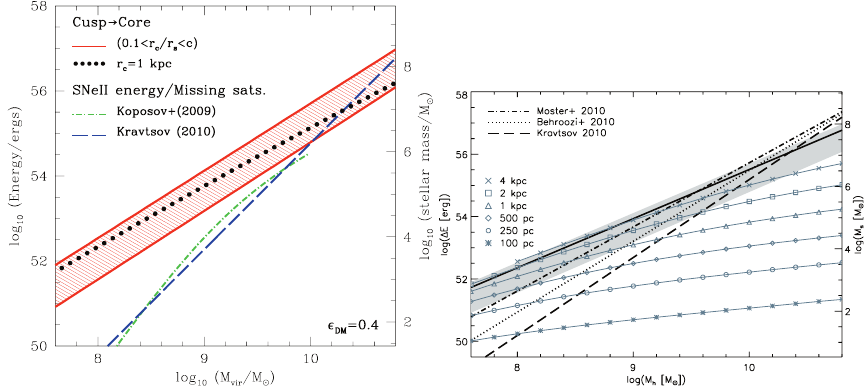
Figure 8. Left panel: SN energetic output with halo mass. The red shaded area represents the minimum energy of SN explosions, ∆ E , needed to generate a core of size 0.1 < r c / r s < c , c , and r s being the concentration parameter and the scale radius of the NFW profile of virial mass M vir , respectively. The dotted black line corresponds to a core of size r c = 1 kpc. The right vertical axis displays the luminosity, in stellar mass, derived from a star formation efficiency F ∗ = F ∗ ( Mvir ) constrained by the number of luminous satellites in our Galaxy. Luminosities are converted into SNeII energy using Equation (6) of Ref. [301] and adopting a strong energy coupling (cid:101) DM = 0.4. The outputs of energy found for SN explosion compatible with the “missing satellite” problem in two different studies [310,311]. The tension between the “core/cusp” and “missing satellite” problems becomes obvious in haloes with M vir < 10 M (cid:12) (panel reproduced from [301]). Right panel: Estimates from Ref. [302] of the energy ∆ E required to convert a dark matter cusp into a core. Similarly to the left panel, the left axis shows SN energy outputs. However, the right axis shows the stellar mass corresponding to ∆ E assuming 100% efficiency ( (cid:101) DM = 1). The energy required to obtain the pseudo-isothermal density profiles, at given fixed core size, yields the solid lines with symbols. The solid black line shows how ∆ E scales with halo mass M h while the limit radius of redistribution of cusp mass r m scale as a fixed fraction of the halo radius r h . The grey area corresponds to the energy estimate of Penarrubia et al. [301], shaded in red in the left panel. The dotted, dashed, and dot-dashed lines display the M s − M h relations of Behroozi et al. [312], Kravtsov [311], and Moster et al. [313] respectively (panel reproduced from